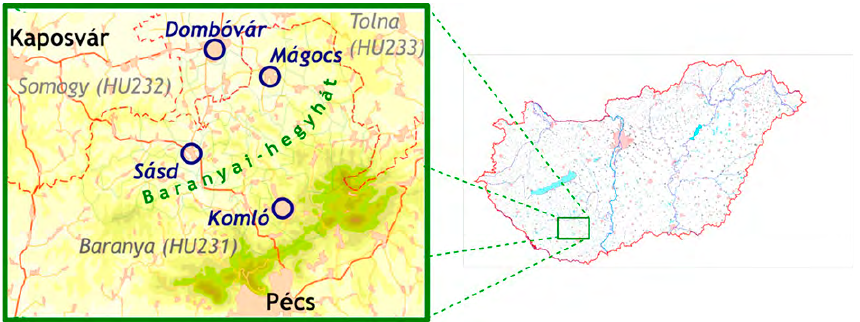
Figure 1. The location and landscape of the Baranyai-Hegyhát